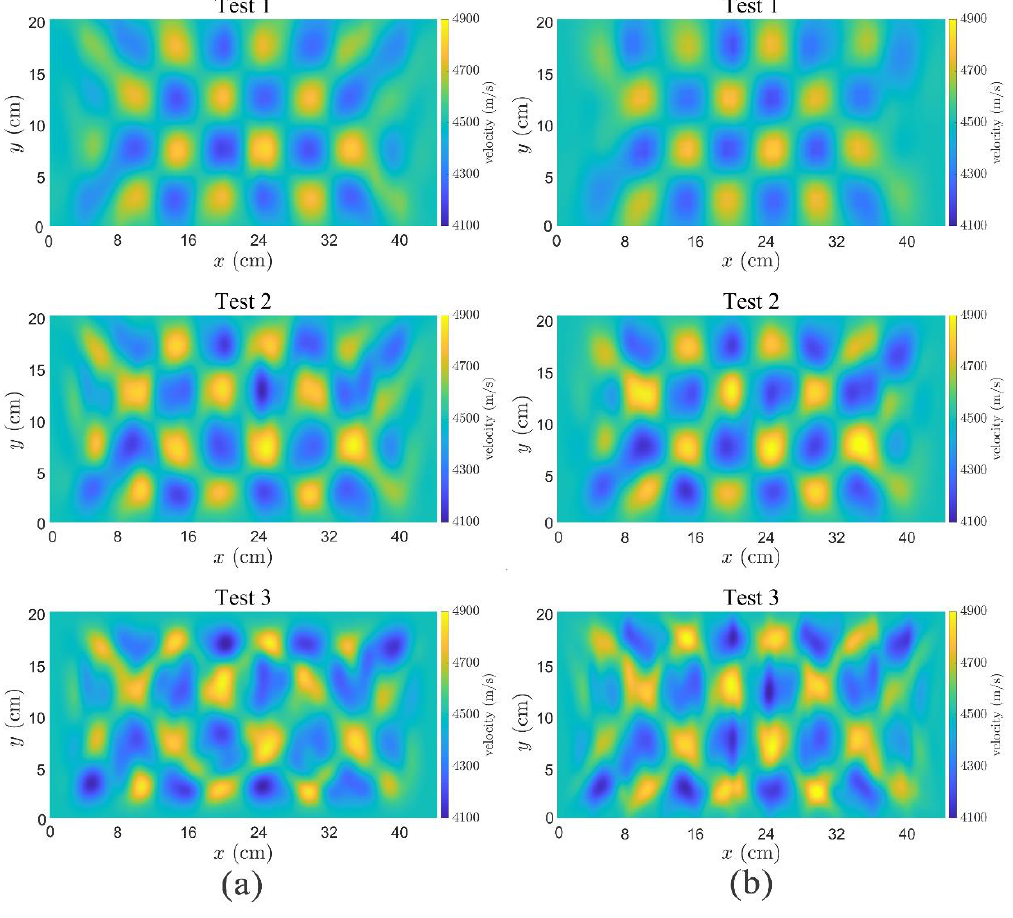
Figure 10. Tomographic results of checkerboard resolution tests with different grid lengths: ( a ) TDAT and ( b ) FAAT.